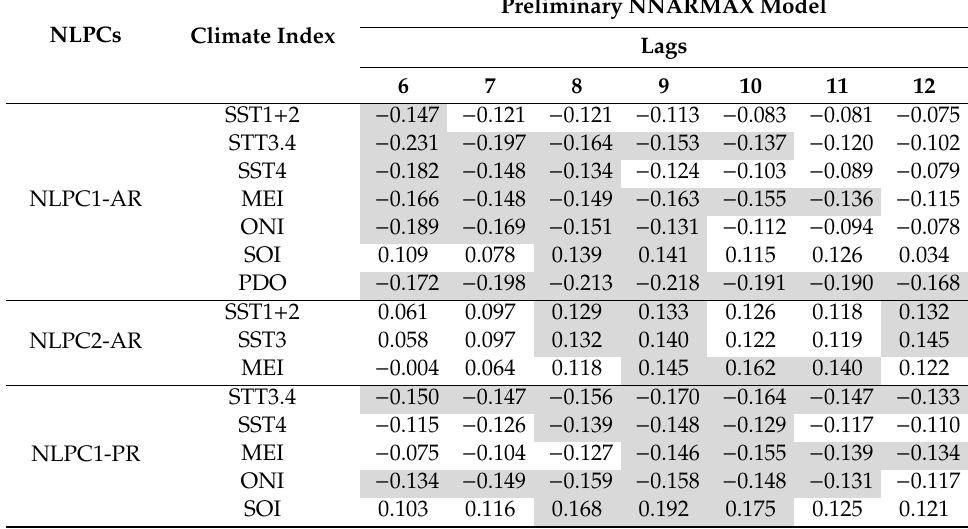
Table 2. Exogenous variables selected as predictors in the preliminary Neural Network Autoregressive Moving Average with eXogenous variables (NNARMAX) model for NLPC1-AR, NLPC2-AR, and